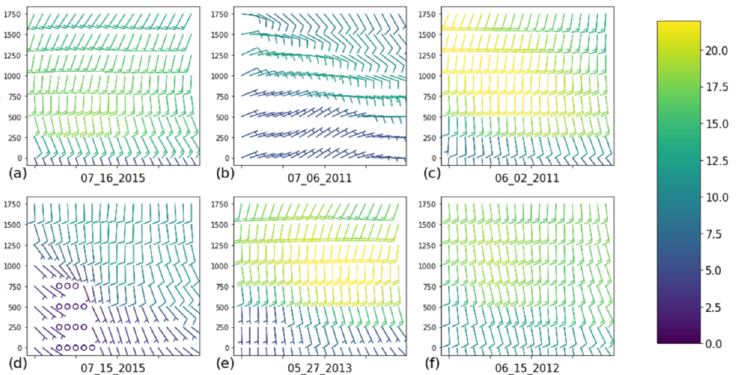
Figure 6. Low-level wind magnitude (ms − 1 ) and direction within the Obs-inflow region for six Type A cases (month, day, and year shown below each panel). Cross-section taken across the entire region from west to east at the halfway position from north to south across domain. Top row ( a – c ) are cases that contained a small X-component distance error, yet a large specific humidity mean error, while the bottom ( d – f ) are cases that contained a large X-component distance error, yet a small specific humidity mean error. Speeds indicated with color bar on the